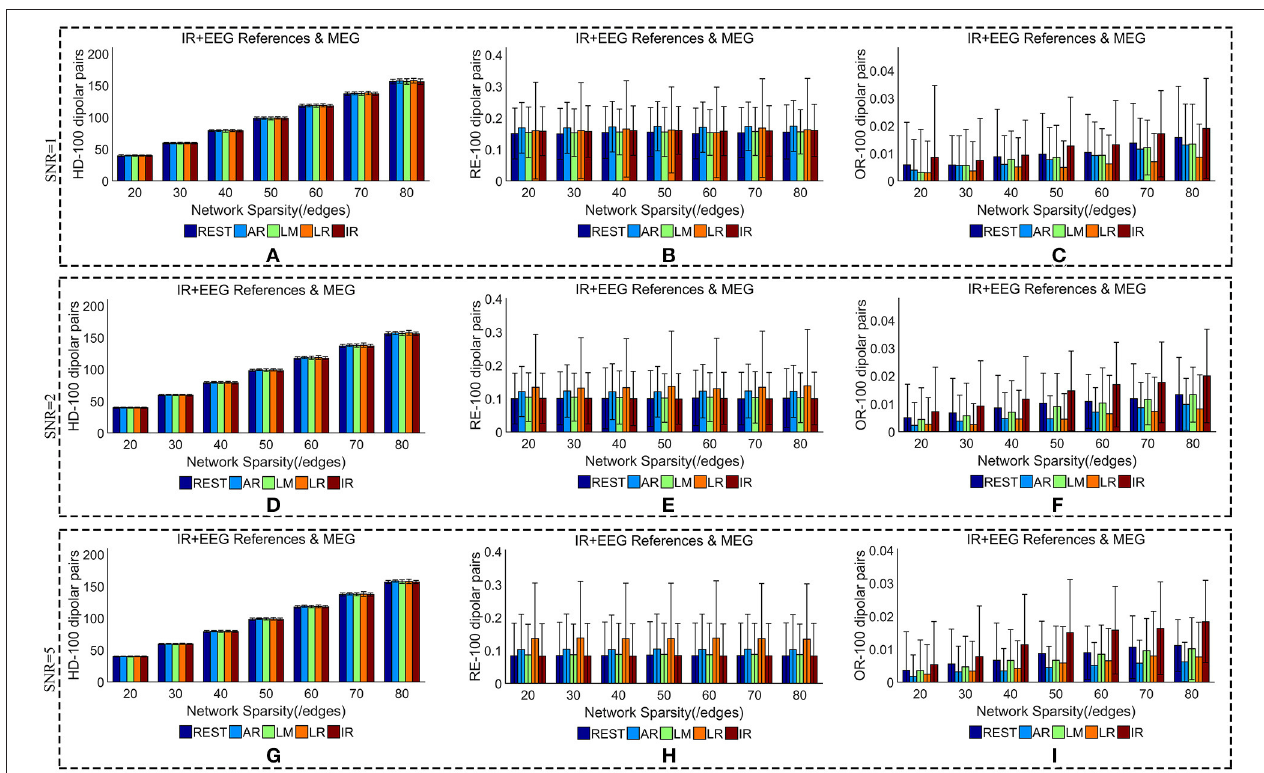
FIGURE 7 | Similarity of sFCTs between EEG (REST, AR, LM, LR, and IR) and MEG based on HD (Hamming Distance), RE (Relative Error), and OR (Overlapping Rate) with different SNRs (1, 2, and 5, respectively). In the case of SNR = 1, different metrics, HD (A) , RE (B) , and OR (C) , were used to measure similarity. In the case of SNR = 2, HD, RE, and OR correspond to (D–F) , respectively. Similarly, in the case of SNR = 3, HD, RE, and OR correspond to (G–I) , respectively. Each bar graph gives results from the four EEG references (REST, AR, LM, LR) and IR under different network sparsities (ranging from 20 to 80 with an interval of